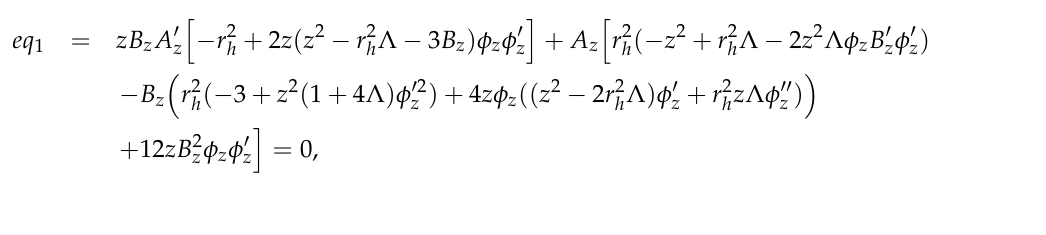
Figure 1. ( a ) The existence curve for scalarized AdS black holes (threshold curve λ SAdS tachyonic instability) in the ( − Λ /3, λ ) plane for three different horizon radii r h = 1,2,4; ( b ) the unstable region is plotted for the horizon radius r h = 1 of SAdS black